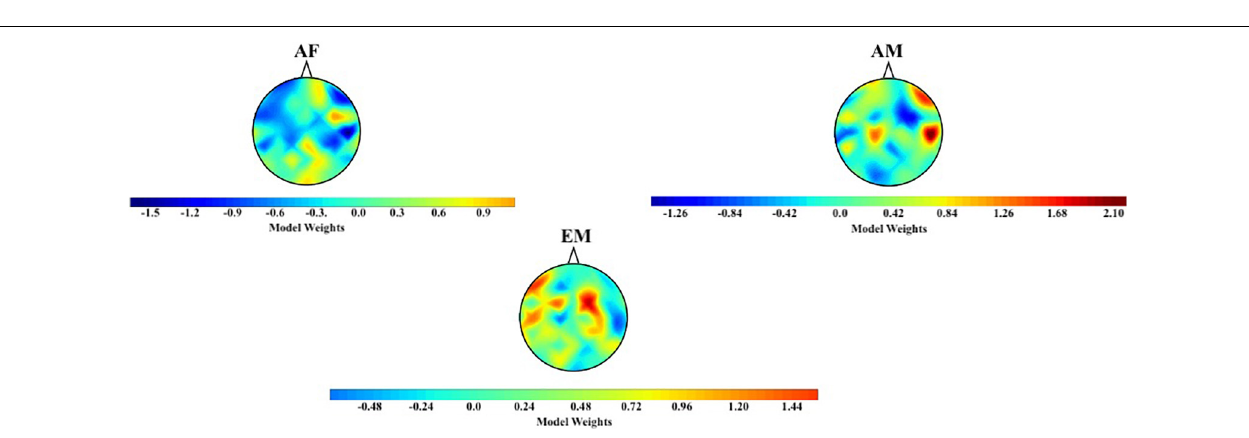
FIGURE 8 | (A) Confusion matrix associated with logistic regression classification of common channels (i.e., F2, F3, C2, P5, P6, and PO3) among the AF, AM, and EM settings. (B) Paired post hoc Wilcoxon rank sum tests between the logistic regression weights associated with AF, AM, and EM settings. The asterisks mark significant differences between the pairs.